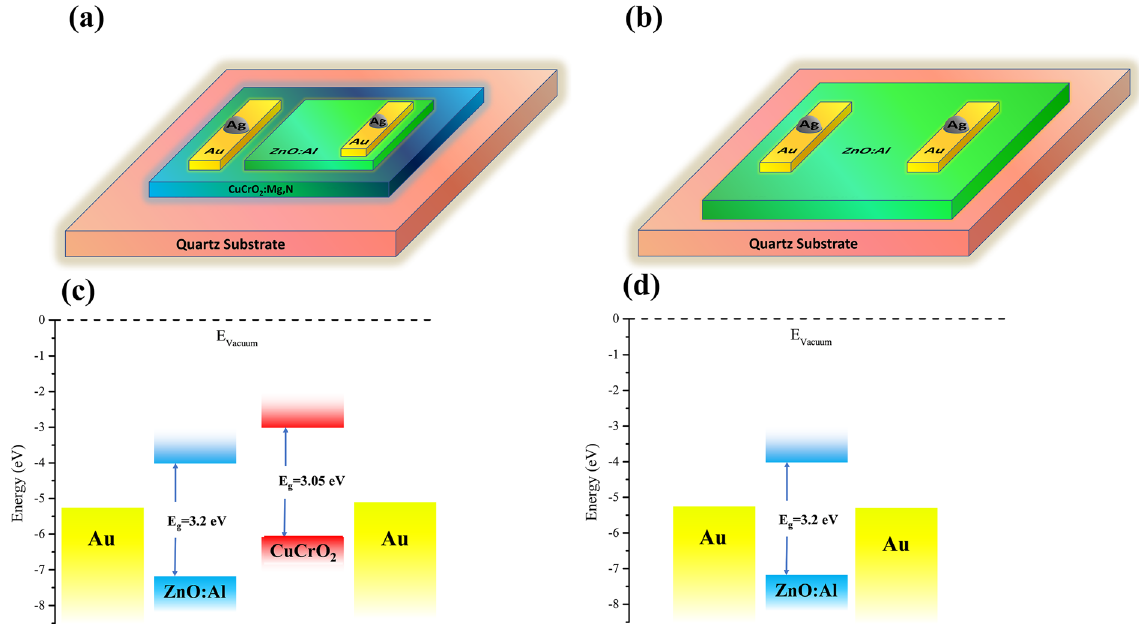
Figure 4. ( a ) Schematic presentation of the photovoltaic configuration with co-doped CuCrO 2 as the p-type layer and AZO as the n-type UV absorber, all deposited on quartz substrate with Ag/Au ohmic contacts. ( b ) Schematic presentation of the photoconductive configuration that is composed of an AZO layer with Ag/Au contacts deposited on quartz substrate. [The schematics are created using Microsoft office PowerPoint 2019 software] ( c ) Band structure diagram of the photovoltaic configuration and ( d ) photoconductive configuration plotted with bandgaps of 3.05 eV 46 and 3.2 eV 47 and electron affinities 15 of 3 and 4 eV, respectively for CuCrO 2 and ZnO